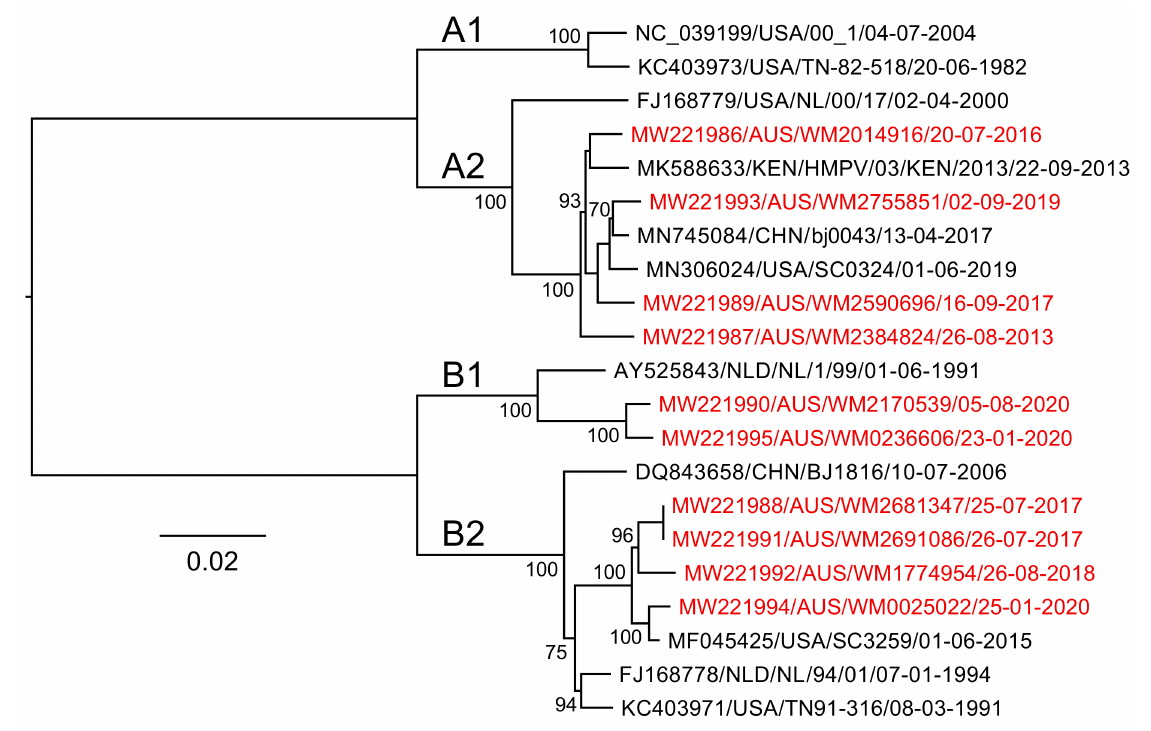
Figure 5. A maximum-likelihood tree constructed using near-full-length human metapneumovirus sequences generated in this study (those colored red). Node supports are indicated, and branch lengths are scaled according to sequence divergence (substitutions per